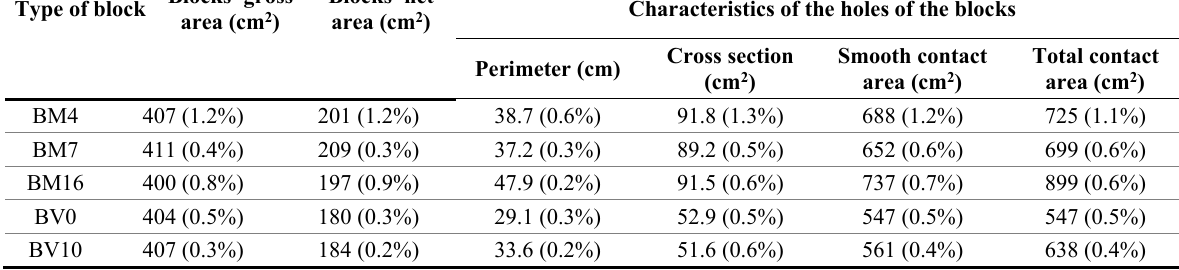
Table 1. Geometric characteristics of the blocks.